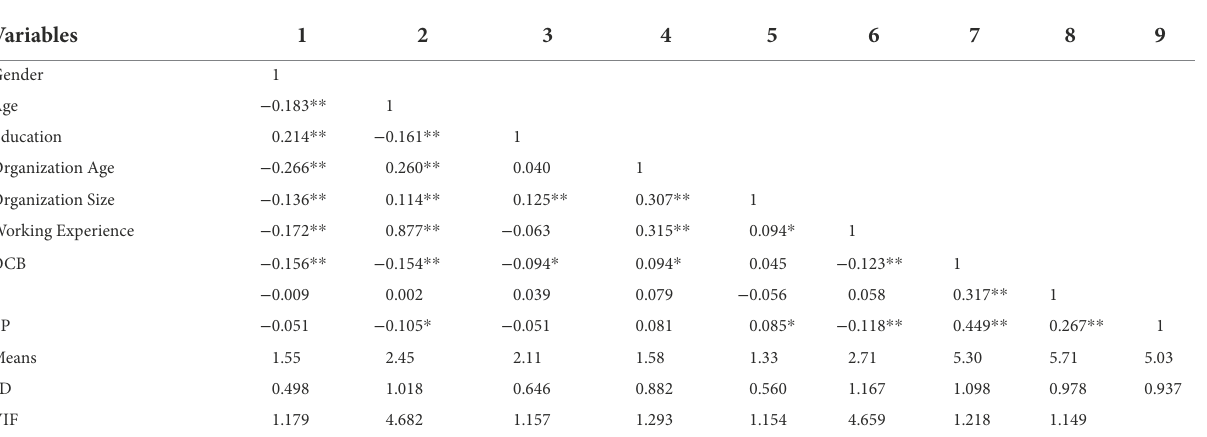
TABLE 4 Descriptive statistics and correlations.